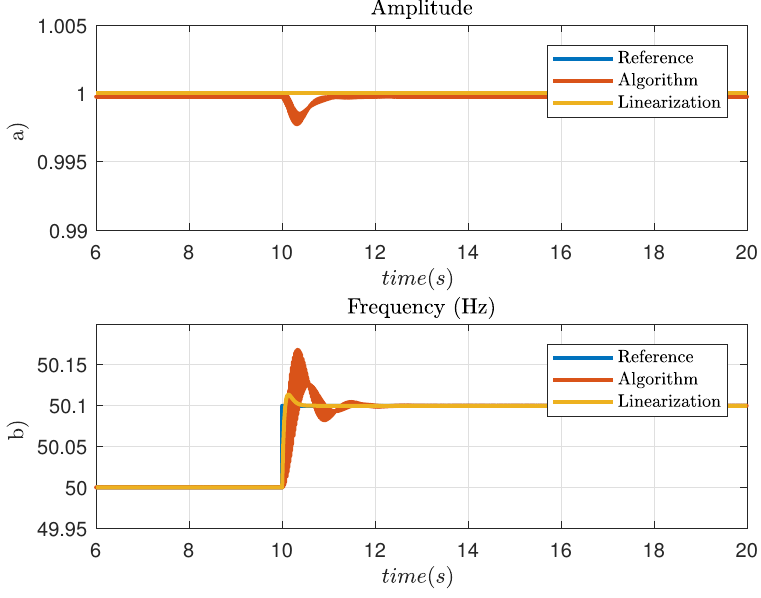
Figure 4. Frequency tracking. ( a ) amplitude output of the algorithm, ( b ) frequency